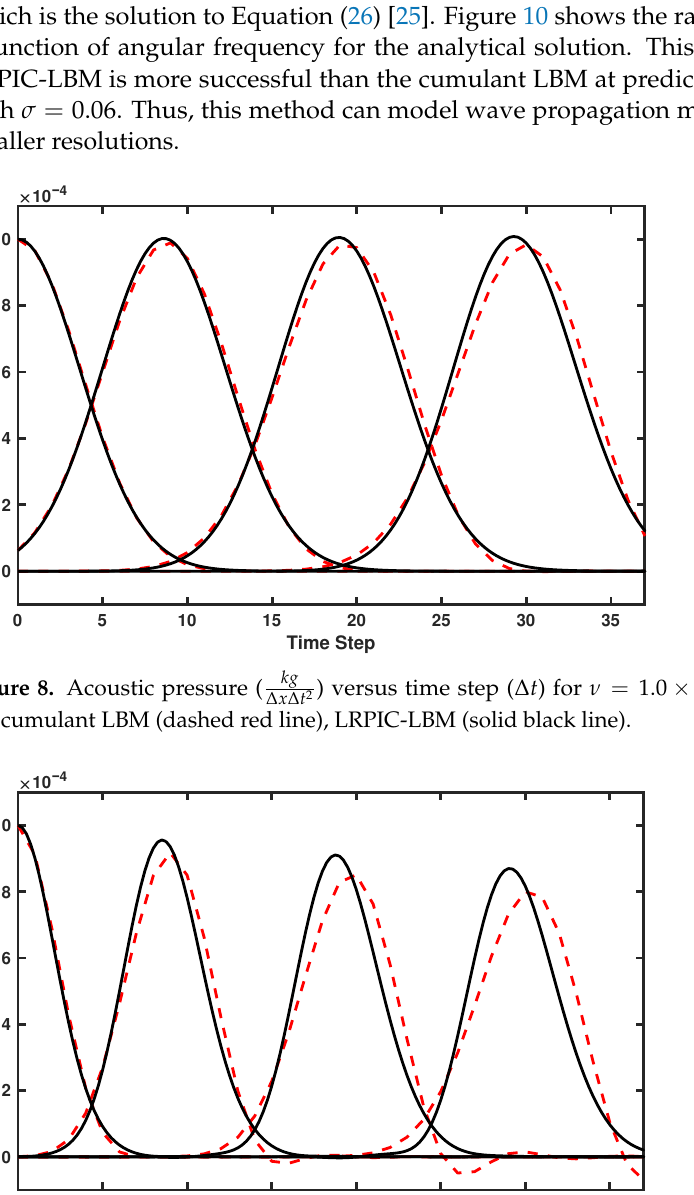
Figure 9. Acoustic pressure( kg ∆ the cumulant LBM (dashed red line), LRPIC-LBM (solid black